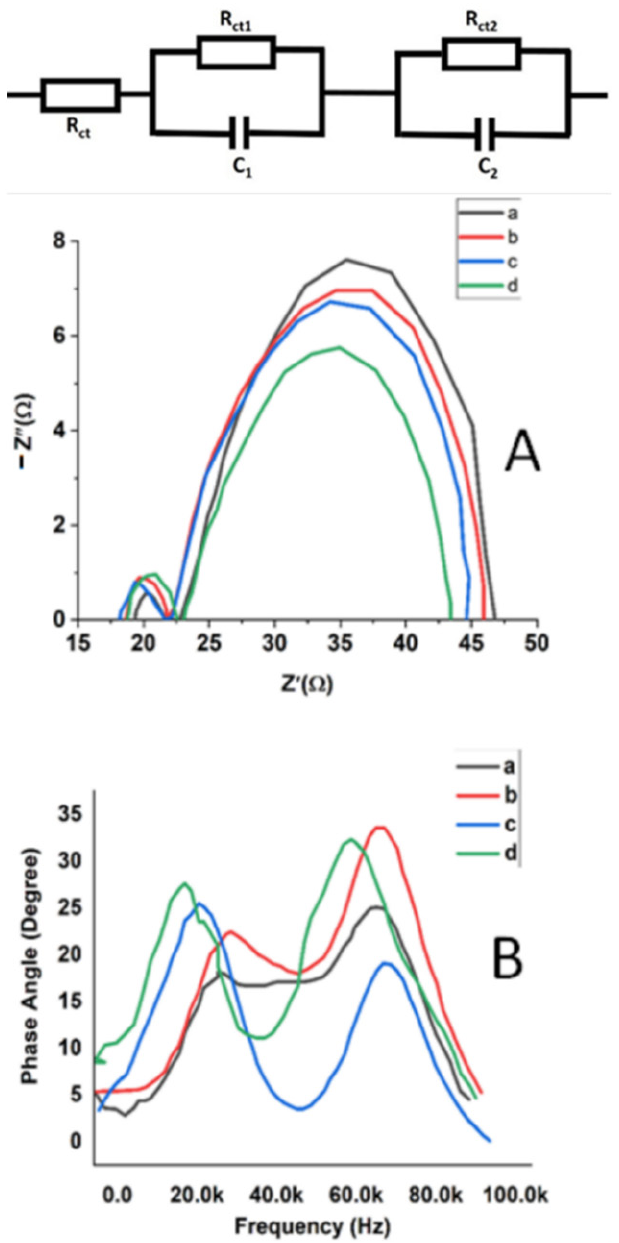
Figure 10. ( A ) Nyquist plots and ( B ) Bode plot of Au (0.0, 0.5, 1.0 and 1.5 wt %)-doped ZnO–Sm nanoparticle films.